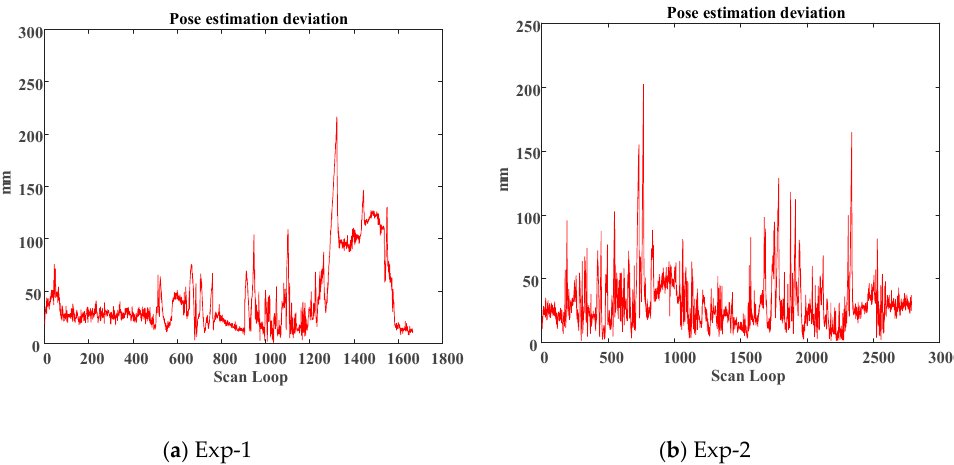
Figure 11. Pose estimation deviation comparison of the first/second experiments.